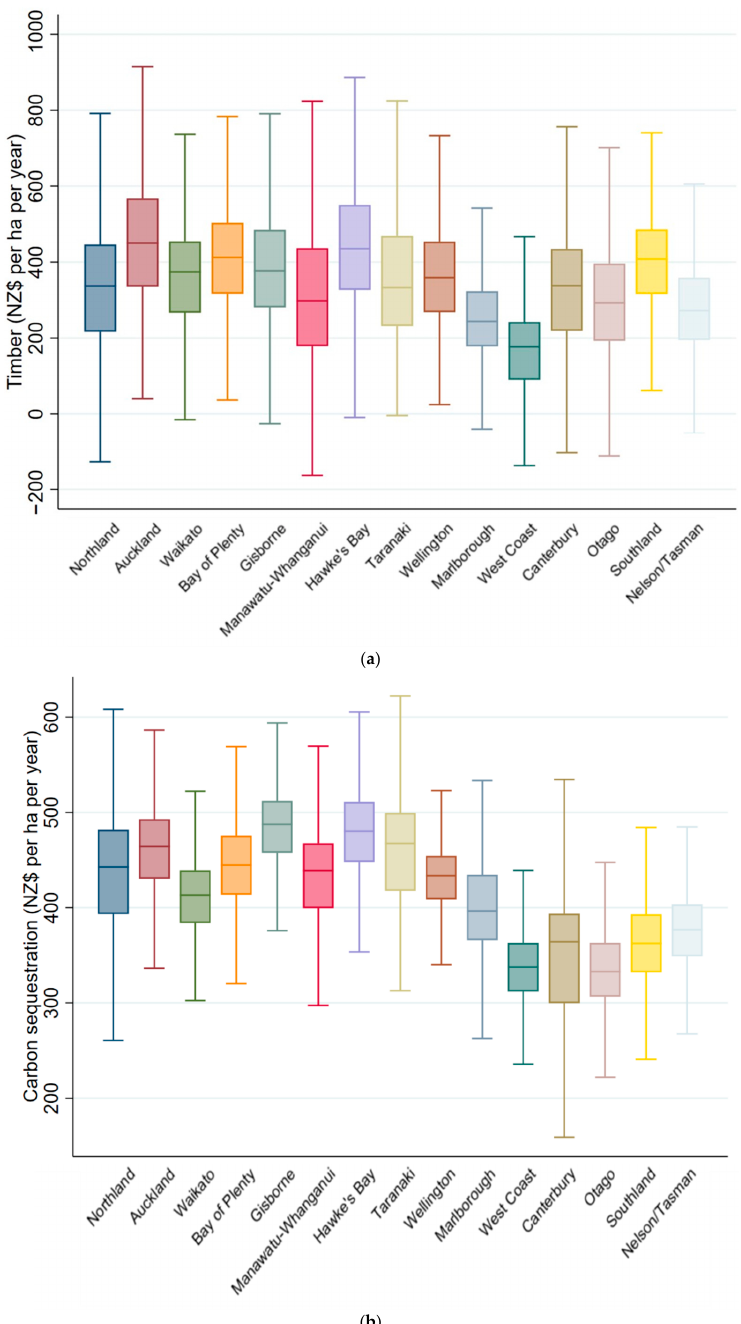
Figure 3. ( a ) Distribution of the annual timber profitability values by region (excludes outside values). ( b ) Distribution of the non-market values of carbon sequestration by region (excludes outside